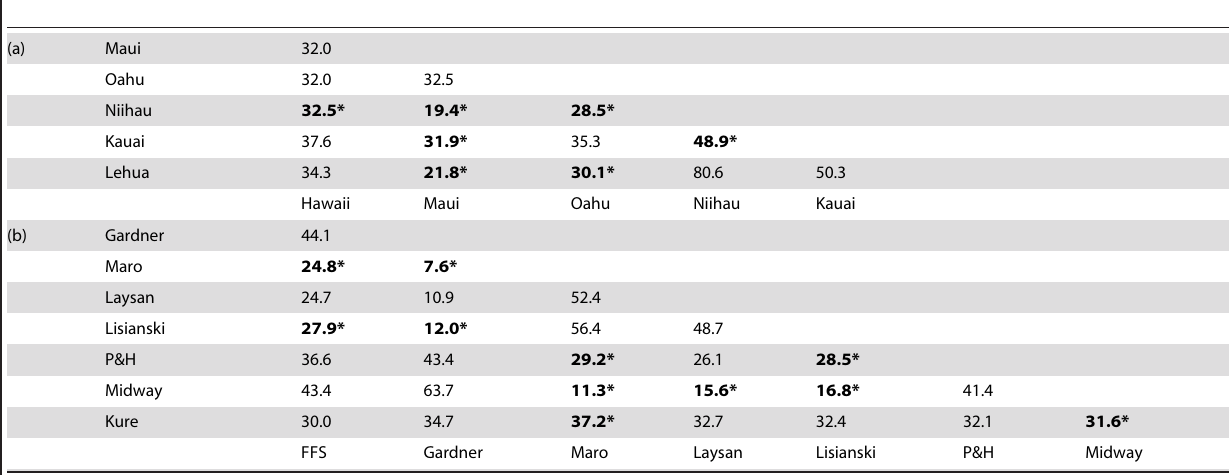
*indicates significantly different from each other (P # 0.01) using permutational analysis of variance pairwise comparisons. Analyses based on 9999 random permutations. P&H, Pearl and Hermes.